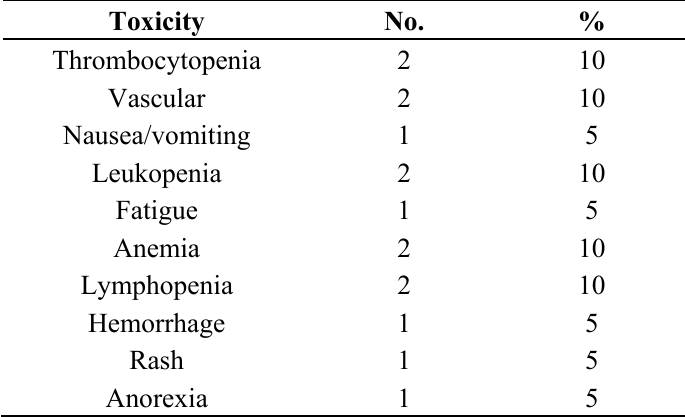
Table 2. Grade 3 or 4